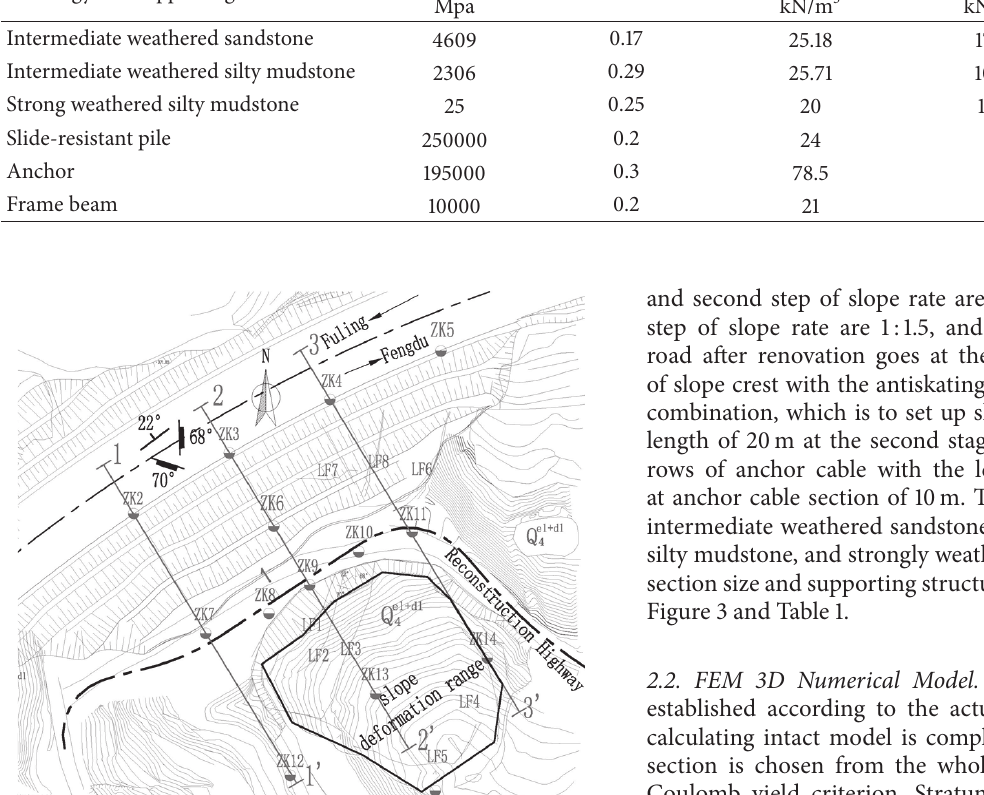
Figure 1: Planar graph of K27